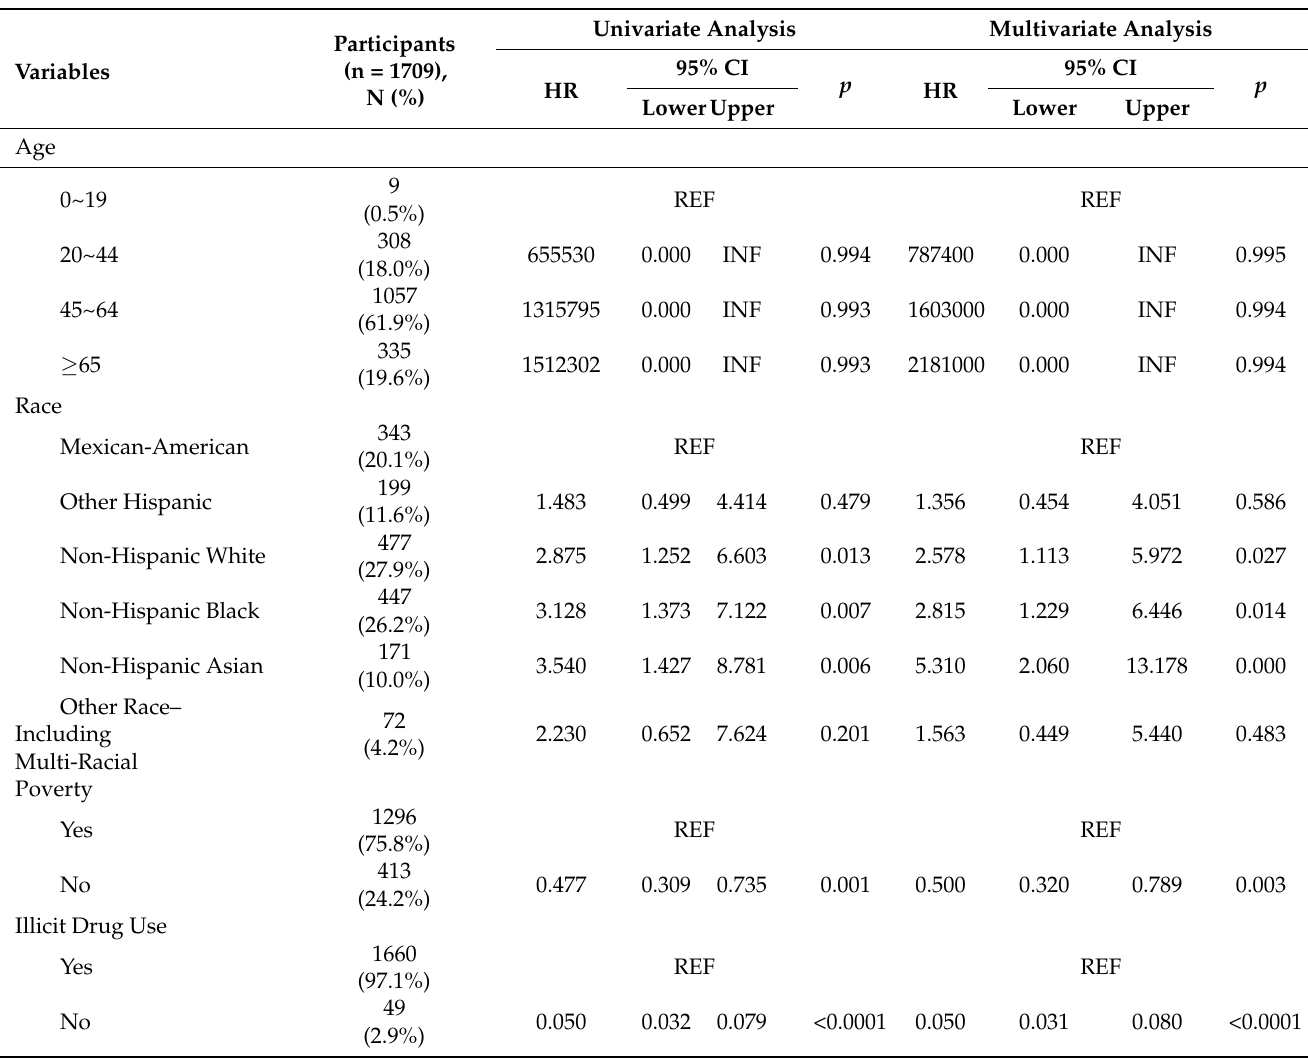
Table 3. Univariate and multivariate hazard ratio and 95% confidence intervals for the risk of hepatitis B or C with diabetes mellitus